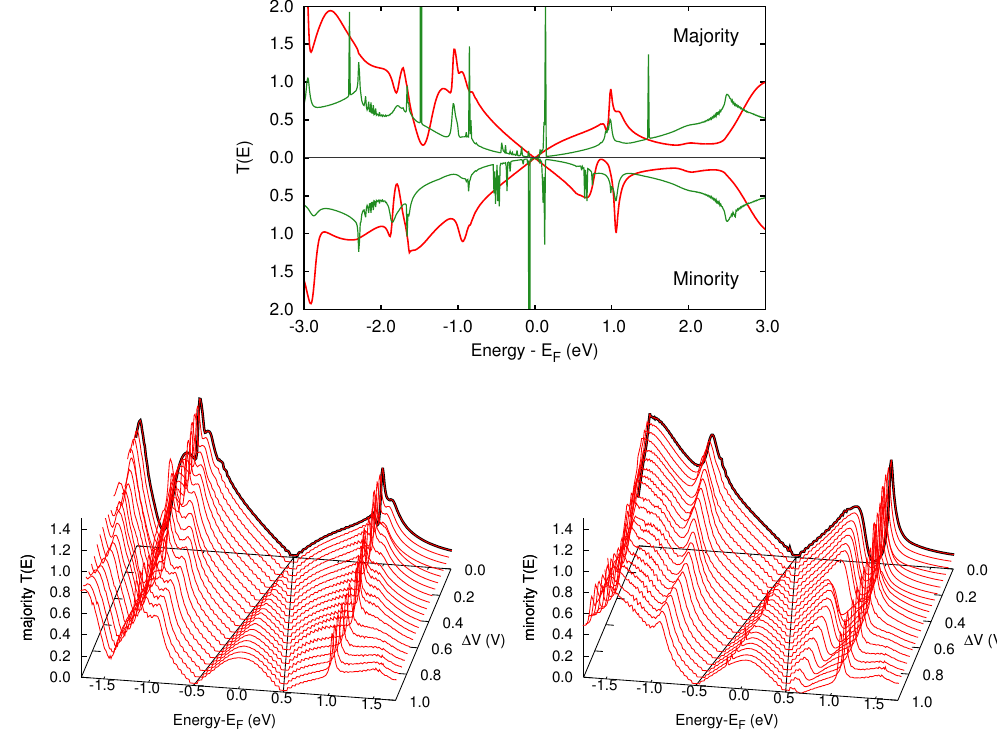
Figure 4. Upper panel: T ( E ) at zero bias of the nanojunction (red line), along with the total DOS (green line). Lower panels: transmission functions of the majority (left) and the minority (right) charge carriers at varying